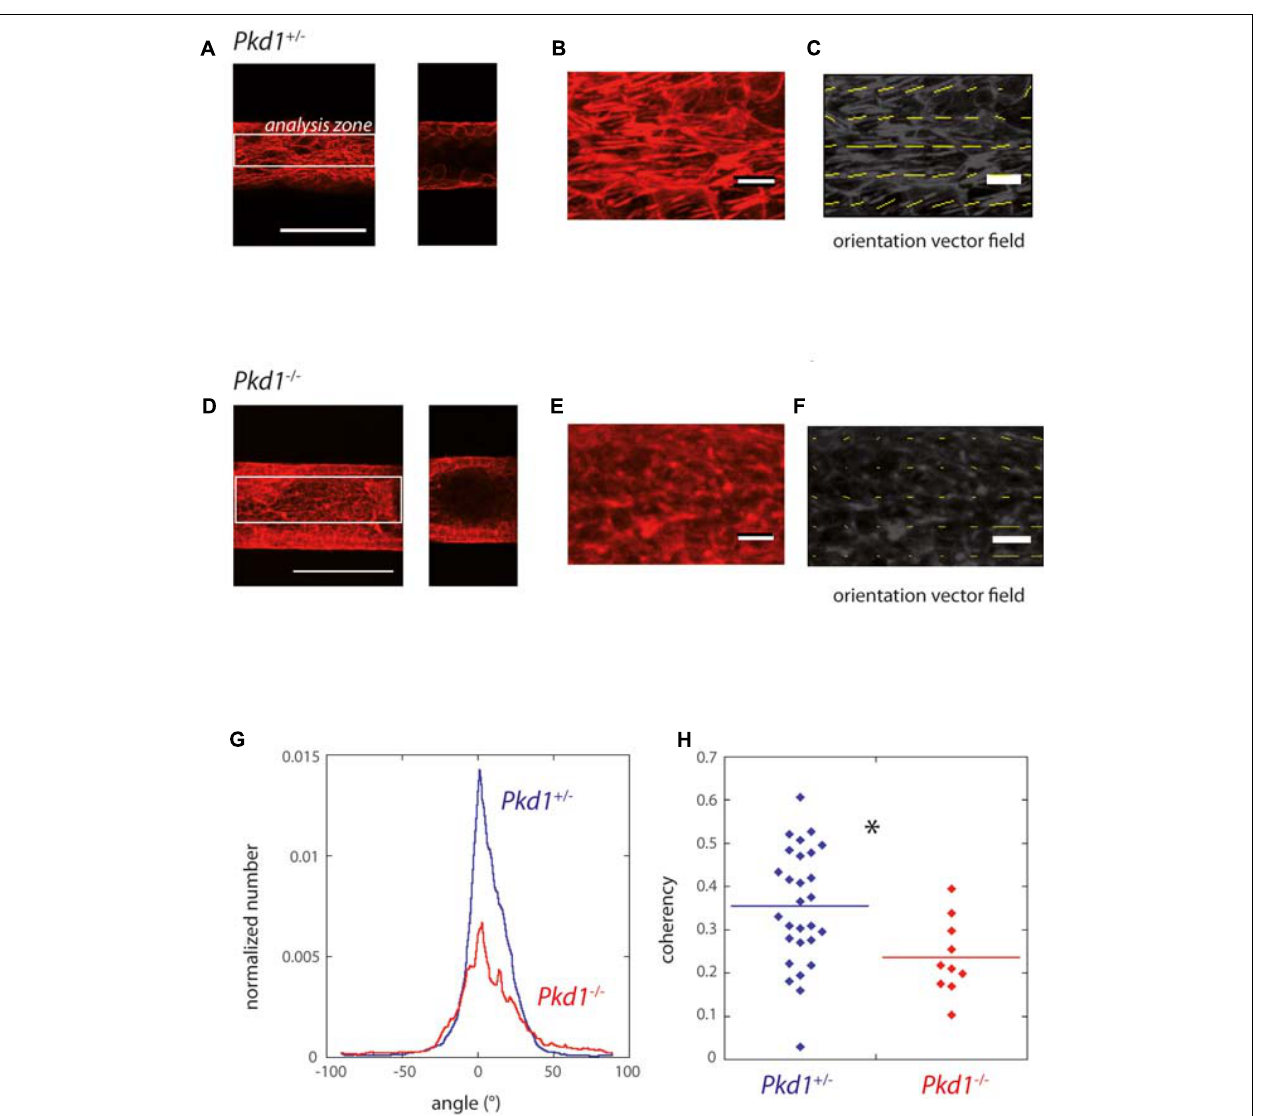
FIGURE 4 | F-actin orientation of PCT Pkd1 +/- and Pkd1 -/- cells in tubes. (A–F) F-actin labeling in Pkd1 +/- (A–C) and Pkd1 -/- (D–F) tubes. (A,D) Left: z projection of the inferior half of the tube is shown, scale bar 100 µ m. Right, confocal section at the middle of the tube. OrientationJ analysis was performed in a central rectangle corresponding to half of the tube (white rectangle in A,D ), in order to get rid of border effects. (B,E) Zoomed part, (C,F) Orientation vector fields (yellow arrows). Magnitude normalized by the strength of orientation (coherency) is represented. Coherency is low in the Pkd1 -/- condition, so that arrows are barely visible in (F) . (G) Distribution of F-actin local orientation as assessed by OrientationJ software for PCT Pkd1 +/- (blue) and Pkd1 -/- (red) cells. The analysis was done at a subcellular scale, with a 2 µ m local analysis window. Histograms given by OrientationJ are pondered by coherency, meaning that the angle determined for a given window has a more important contribution if there is a clear-cut local orientation. Each histogram is normalized by the size of the analyzed area (in pixels 2 ) before averaging. The analysis was performed on pooled coating conditions (laminin, ECM and collagen), with the majority of tubes corresponding to laminin coating in Pkd1 -/- and Pkd +/- conditions. (H) Mean coherency (per pixel) for PCT Pkd1 +/- (blue) and Pkd1 -/- (red) cells. ∗ Statistically significant difference with p < 0.05. Each point corresponds to one